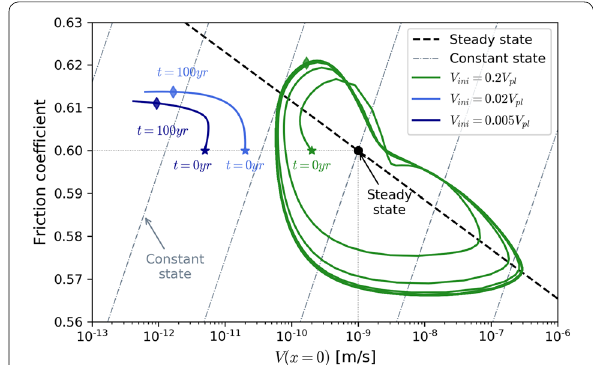
Fig. 9 Trajectory of ( f , V ) at the center of the patch under different initial conditions. Green, light blue, and blue lines represent the cases with V ini = 0.2 V pl , 0.02 V pl , and 0.005 V pl , respectively. Diamonds indicate t = 100 year